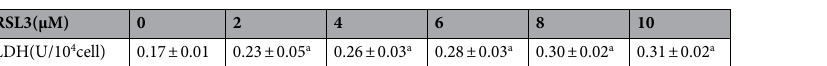
Table 8. Effects of different concentrations of RSL3 on the rate of LDH release from BeWo cells ( X + S ). a Compared with 0 μM group P < 0.05.